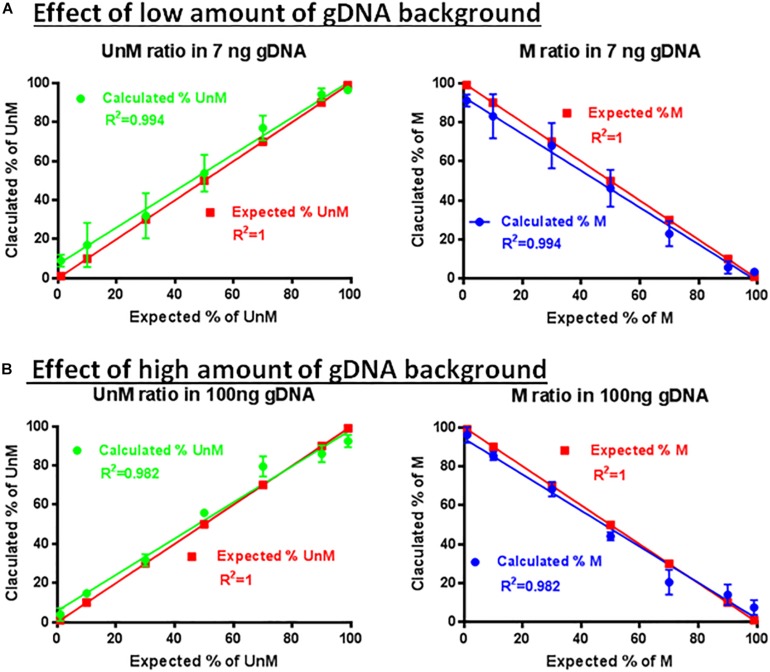
Effect of non-specific gDNA on the specificity and sensitivity of ddMSP. Combinations of different ratios of unmethylated/methylated plasmids (1/99, 10/90, 30/70, 50/70, 70/30, 90/10, and 99/1) in the presence of low (A) or high amounts (B) of non-specific gDNA as background. Mixture analyzed by ddPCR using primers specific to TSDR and probes for methylated and unmethylated CpGs. Linear regression analysis for methylated and unmethylated targets showed no effect of non-specific background. The data shown are the average with standard deviation (SD) of three repeats.